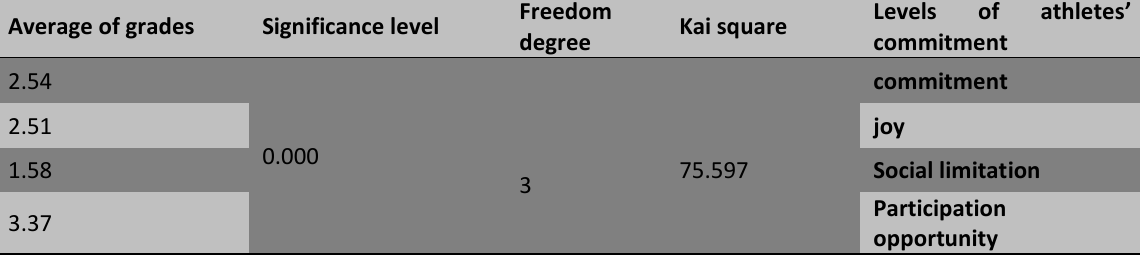
Table 4. Results of Friedman test , the difference between athletes’ commitment